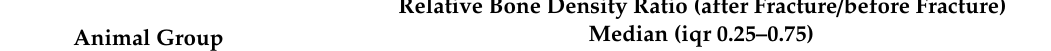
Table 1. Ratios of the bone densities measured at 4th and 24th week after the fracture to the initial bone densities (in two hours after